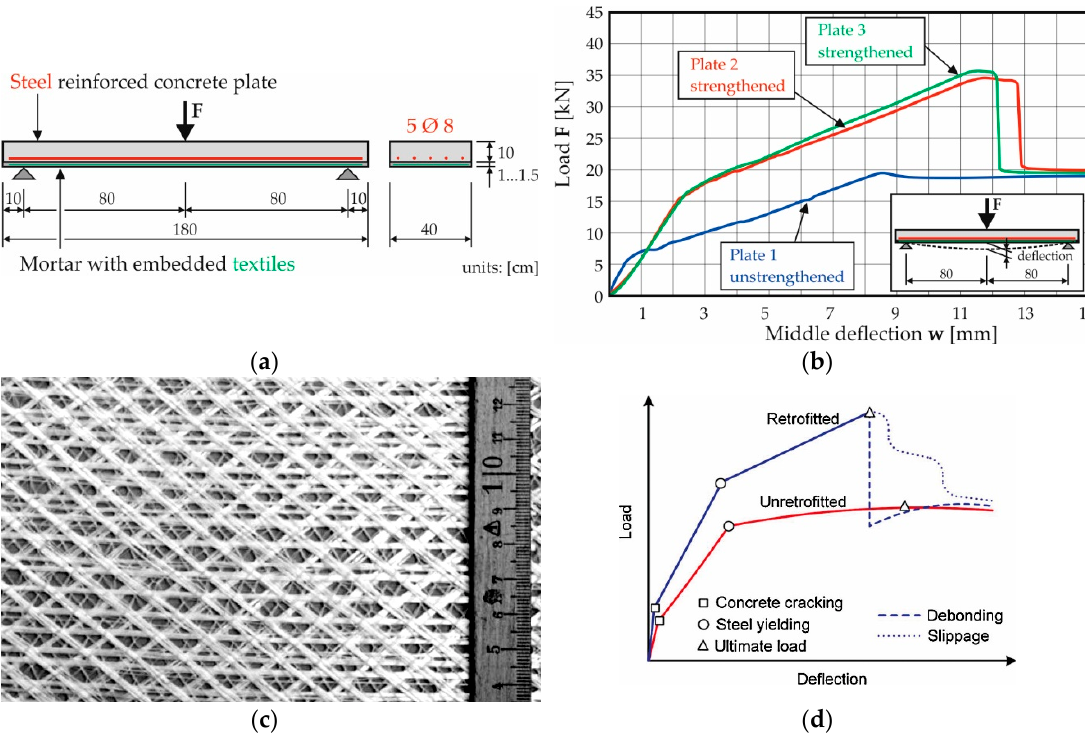
Figure 1. First test on reinforced concrete (RC) slabs strengthened with textile reinforced concrete (TRC) in Germany—( a ) test set-up acc. to Reference, ( b ) used textile made of alkali-resistant (AR) glass, produced by the Institute for Textile and Clothing Technology of TU Dresden, ( c ) test results (( a – c ) reproduced and modified with permission from [31], Institute of Concrete Structures, TU Dresden, 1997) and ( d ) principle behavior of TRC-strengthened RC plates or beams (reproduced from Koutas et al. [22] on the basis of the Creative Commons Attribution license (http://creativecommons.org/licenses/by/4.0/) under which this article open access was published, ASCE Library, 2019).